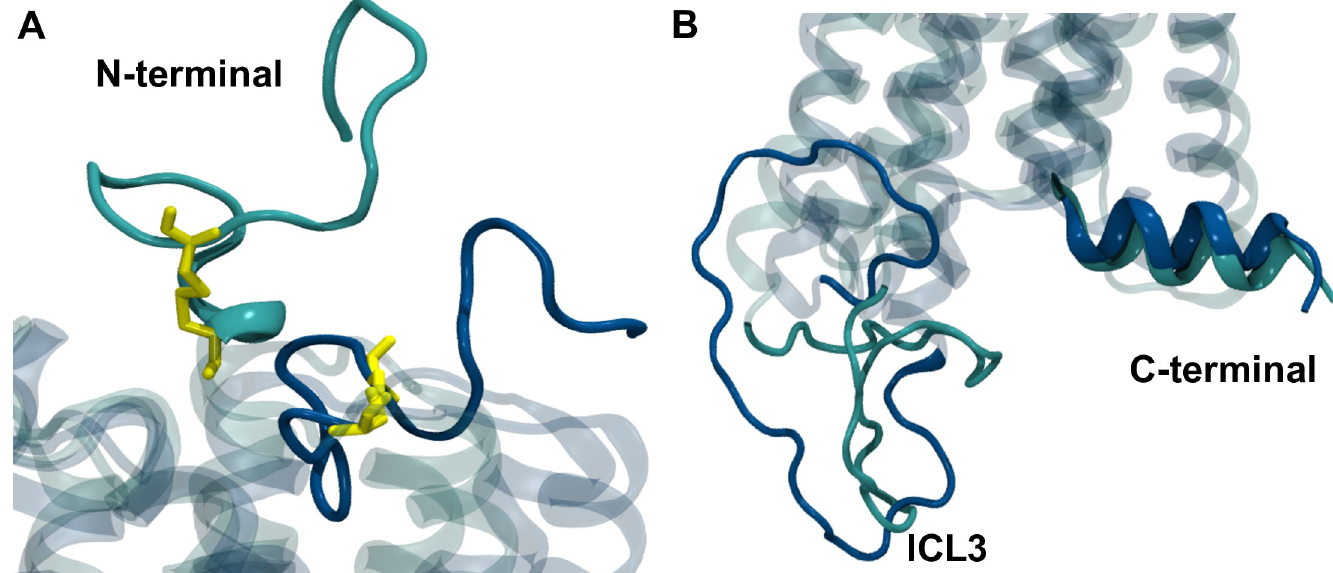
Fig 3. Differences observed in the CB 1 R models bound to agonist and to antagonist. (A) Difference in the N-terminal region, the C98-C107 disulfide bond is shown in yellow licorice representation. (B) Different distance between the ICL3 and the C-terminal. CB 1 R model bound to agonist is shown in cyan and to antagonist in blue.